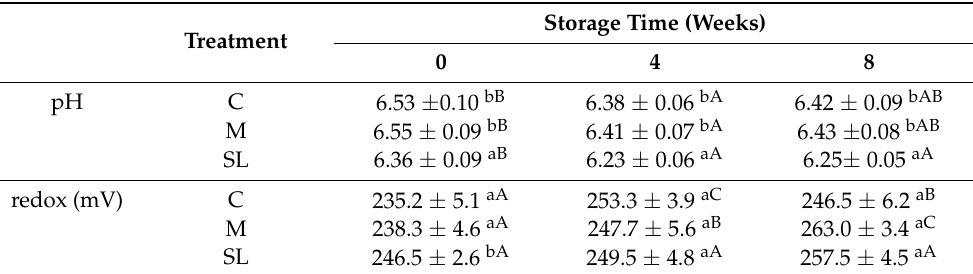
Table 1. Values of pH and oxidation-reduction potential (redox) of the model meat products (means ± standard